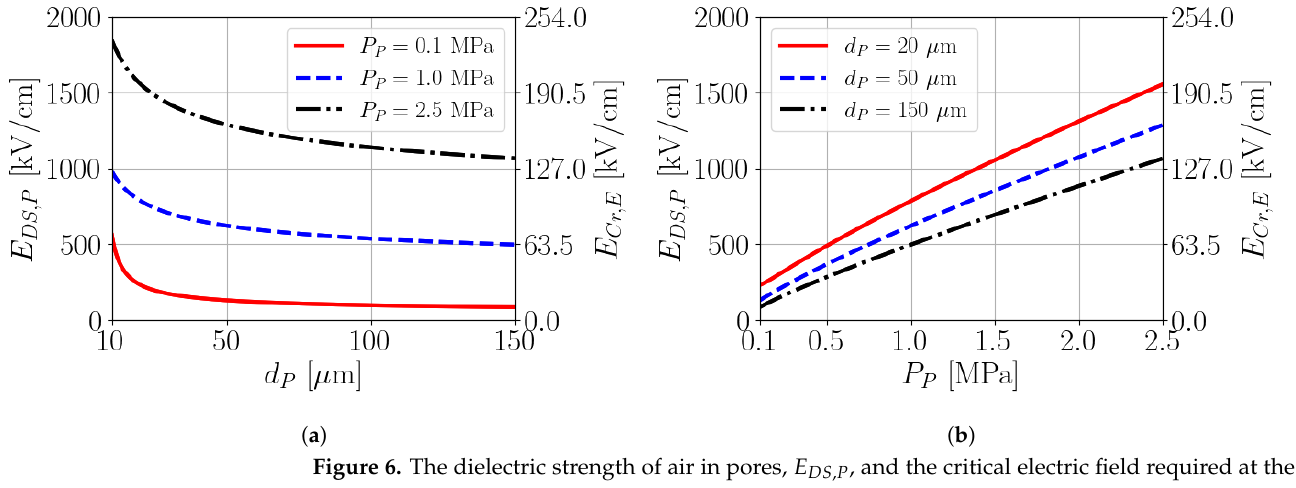
Figure 6. The dielectric strength of air in pores, E DS , P , and the critical electric field required at the electrodes, E Cr , E , to induce an electric field equal to the dielectric strength of air. Both variables are given as a function of ( a ) the pore size, d P , and ( b ) the pore-fluid pressure, P P